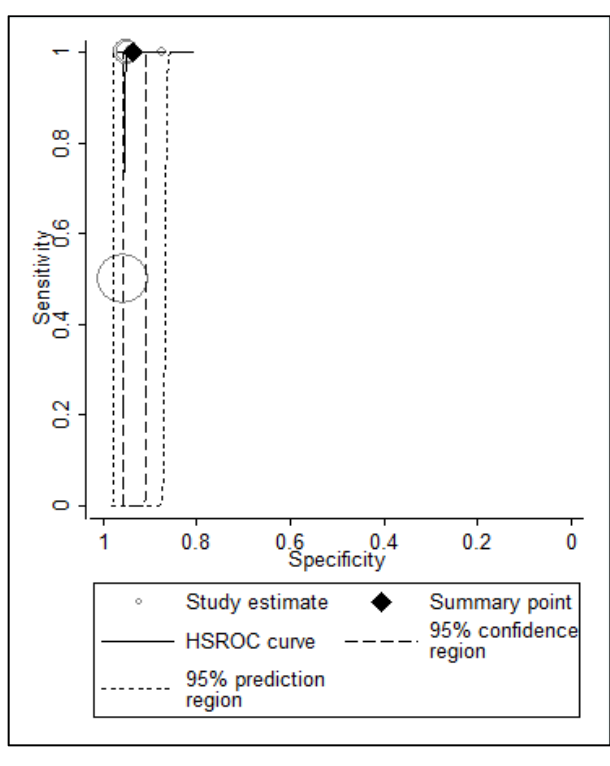
Appendix Figure B4. Summary Receiver Operator Characteristic (SROC) Curves for the detection of triploidy using the first trimester combined test